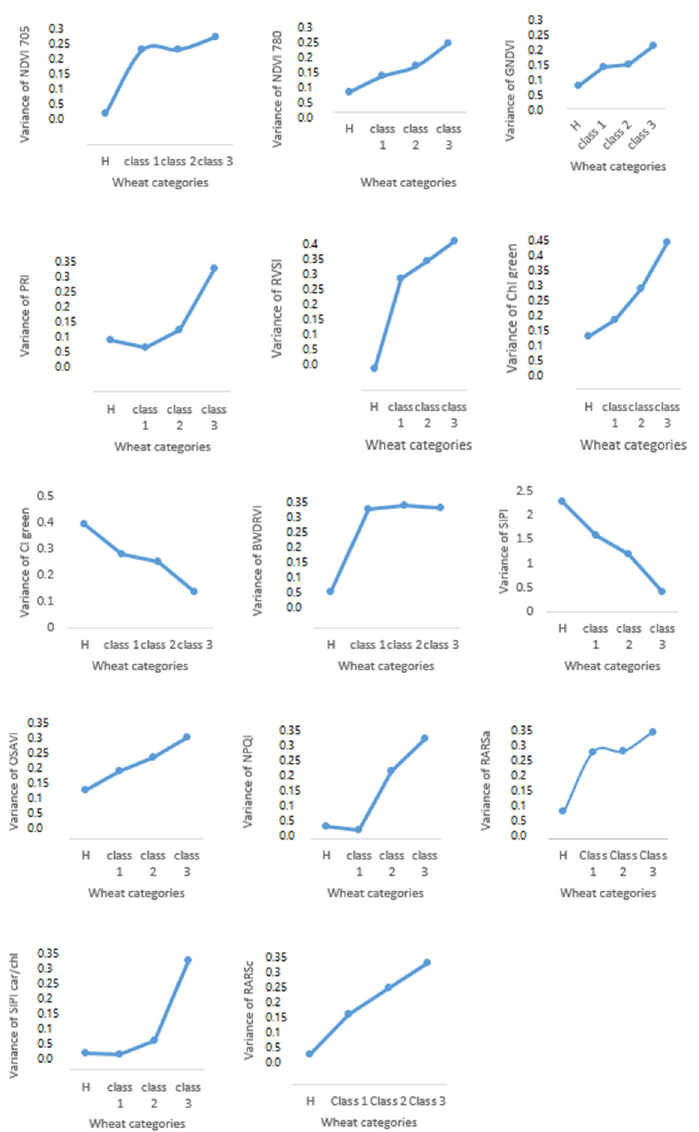
Figure 7. The variation of fourteen vegetation indices in three different classes.